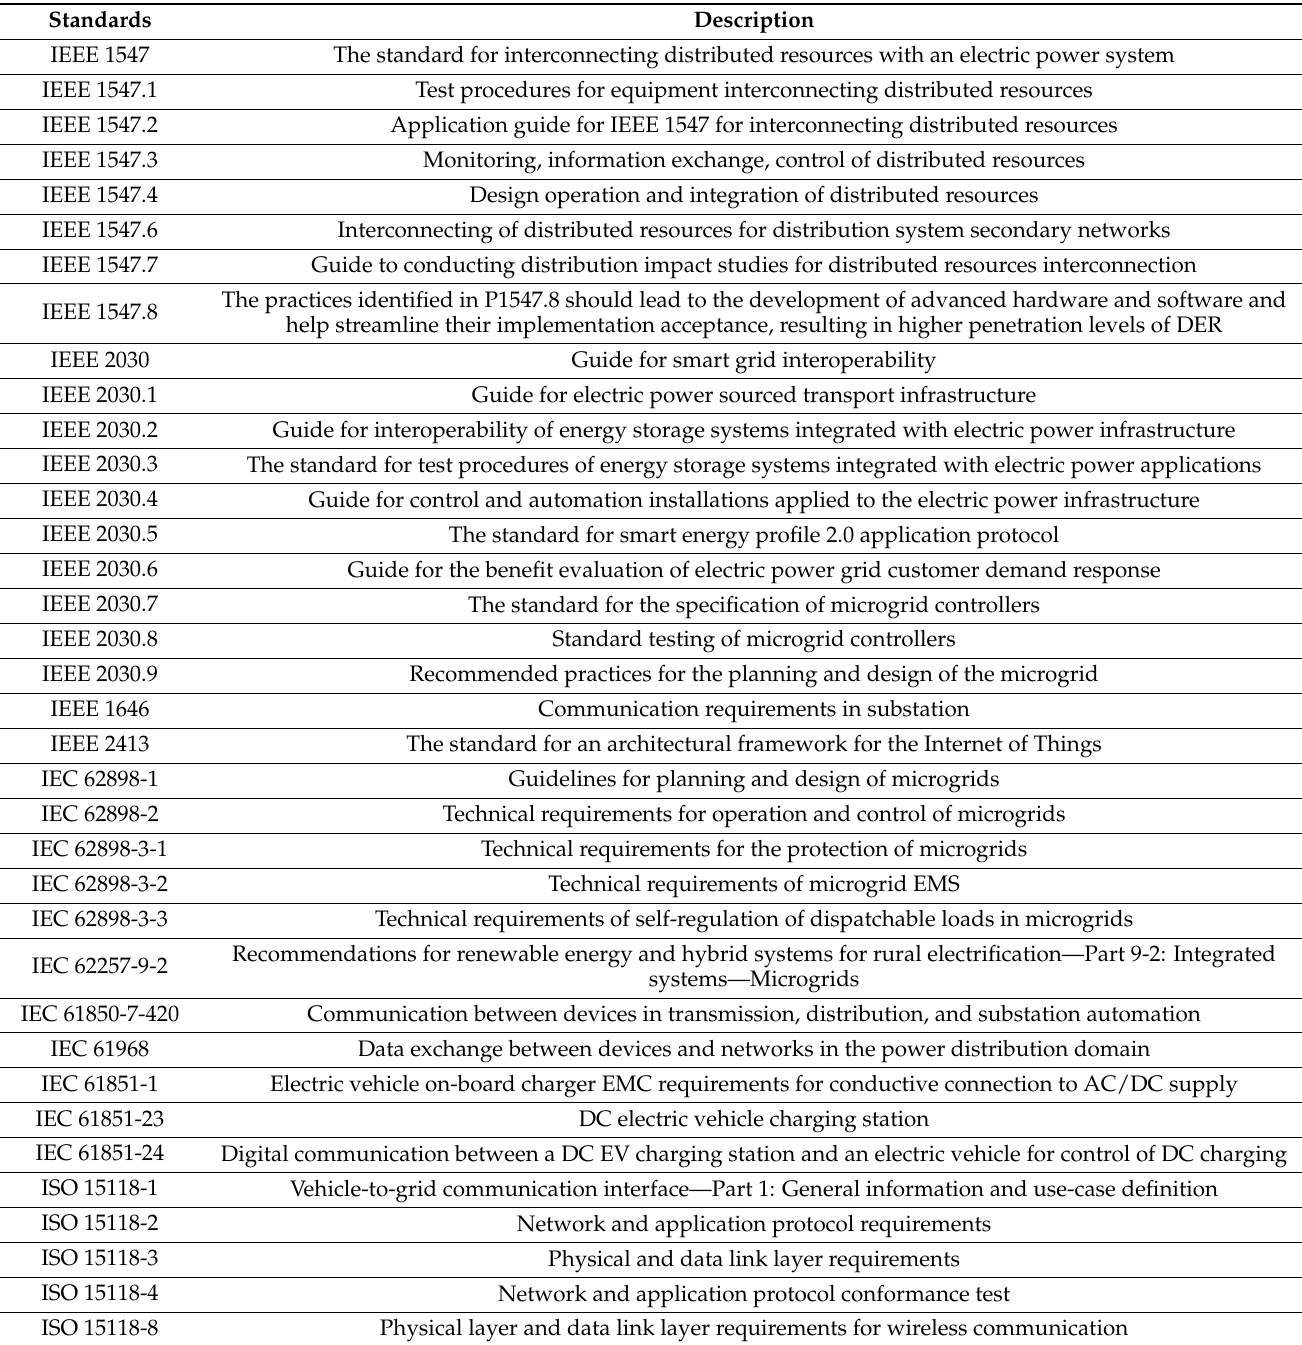
Table 11. Standards for microgrids and electric